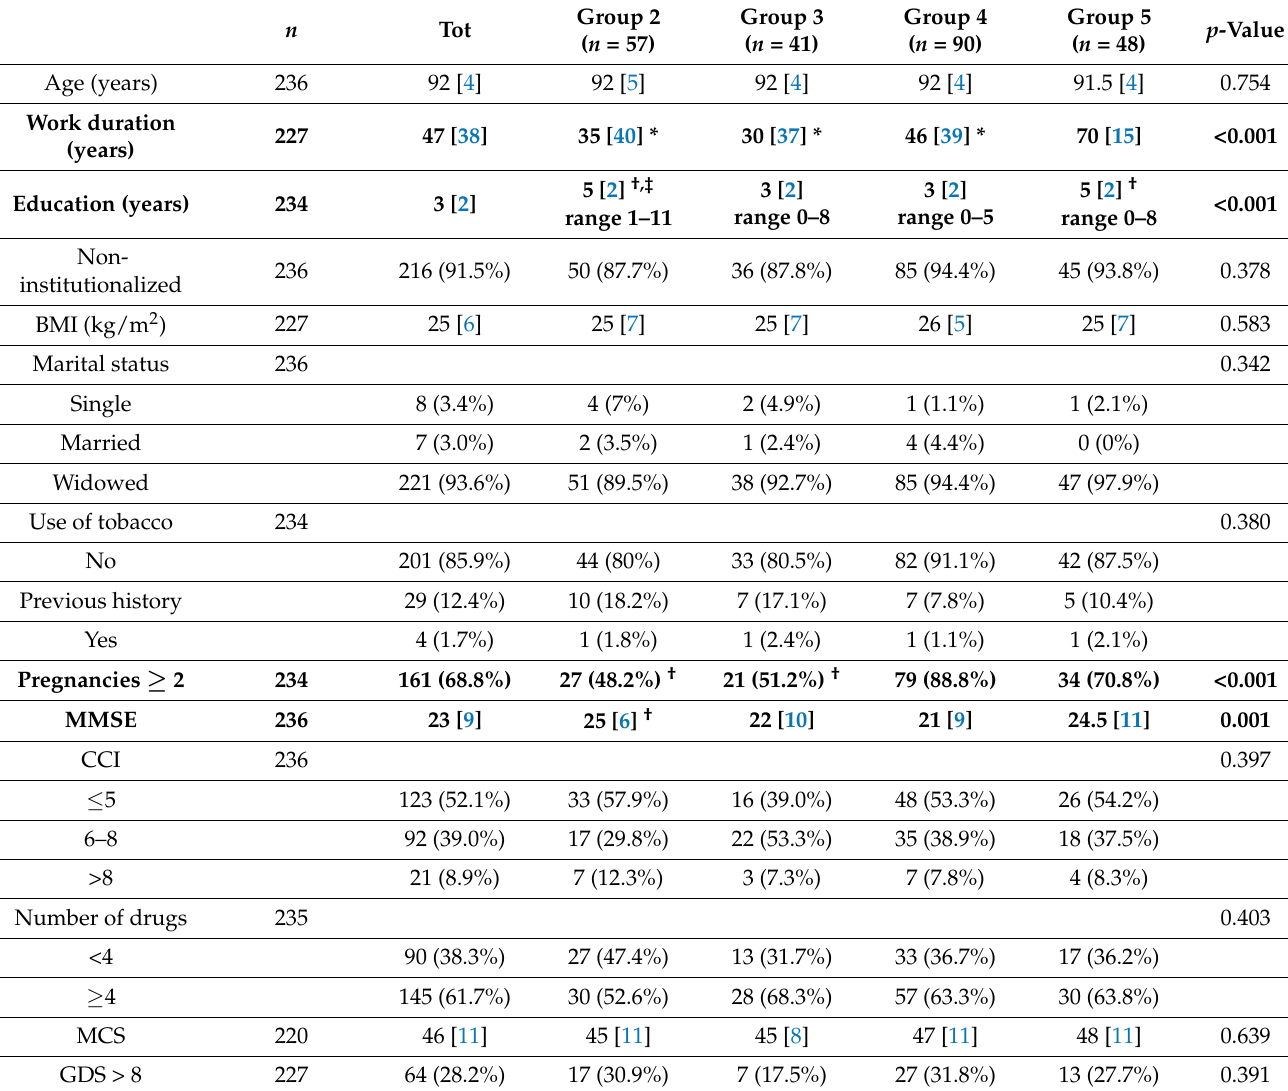
Table 1. Sociodemographic characteristics and general health of all participants and stratified by occupational